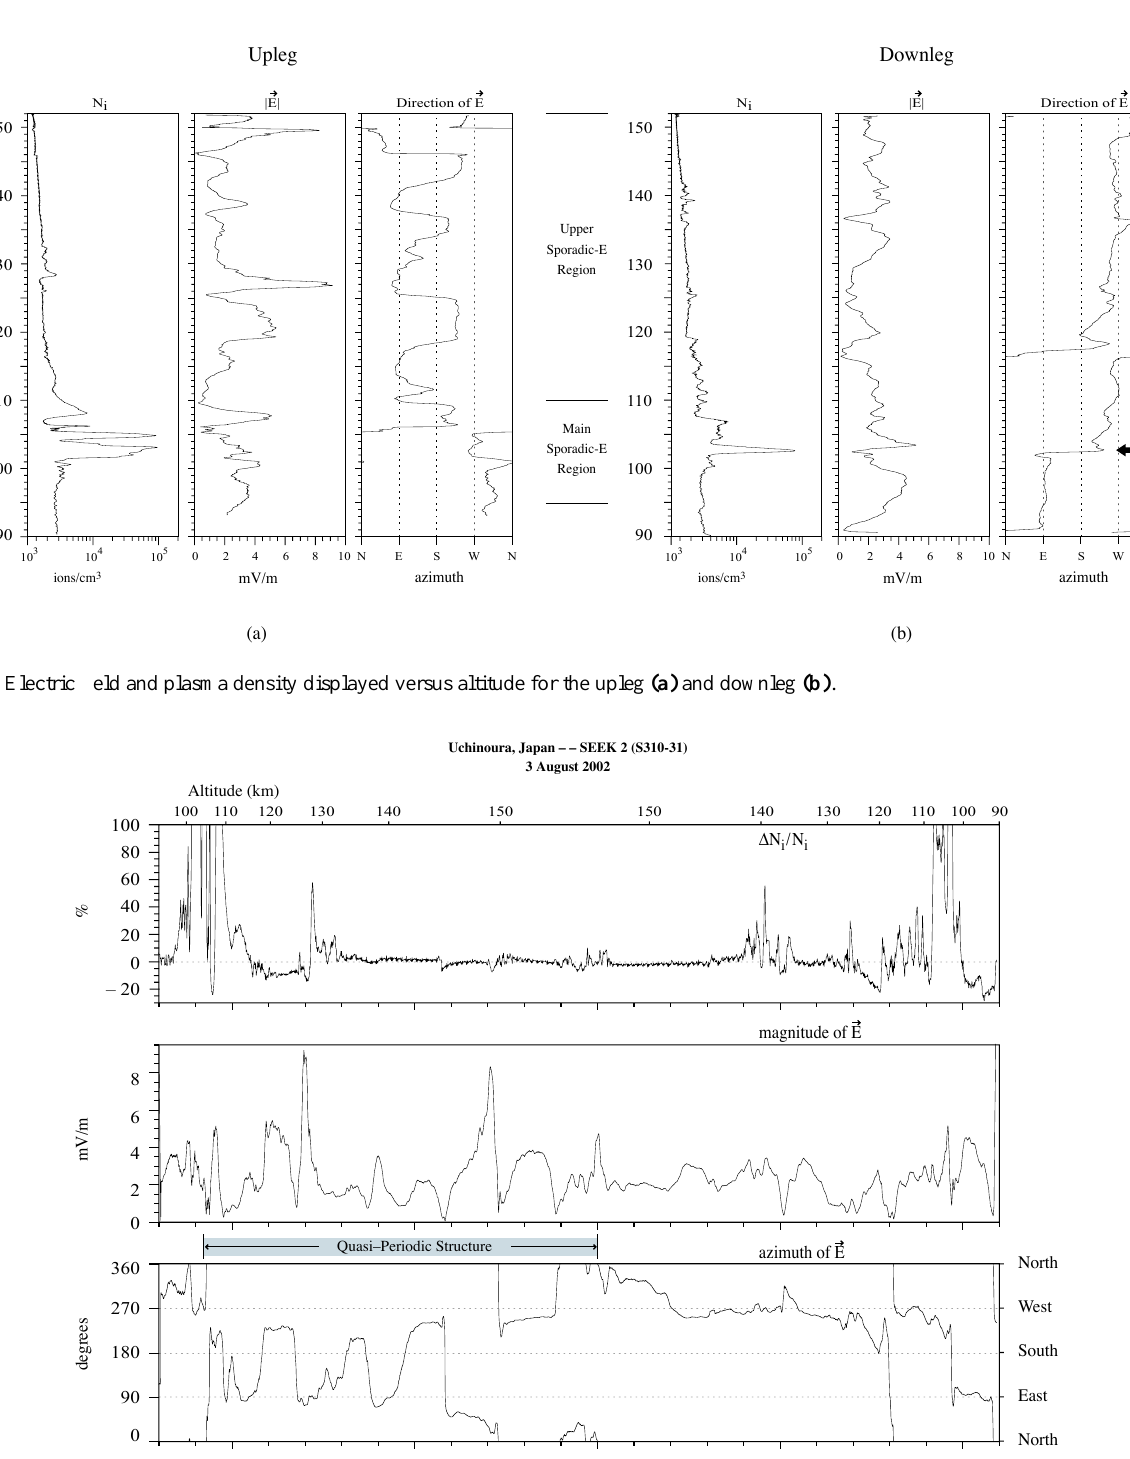
Quasi—Periodic Structure